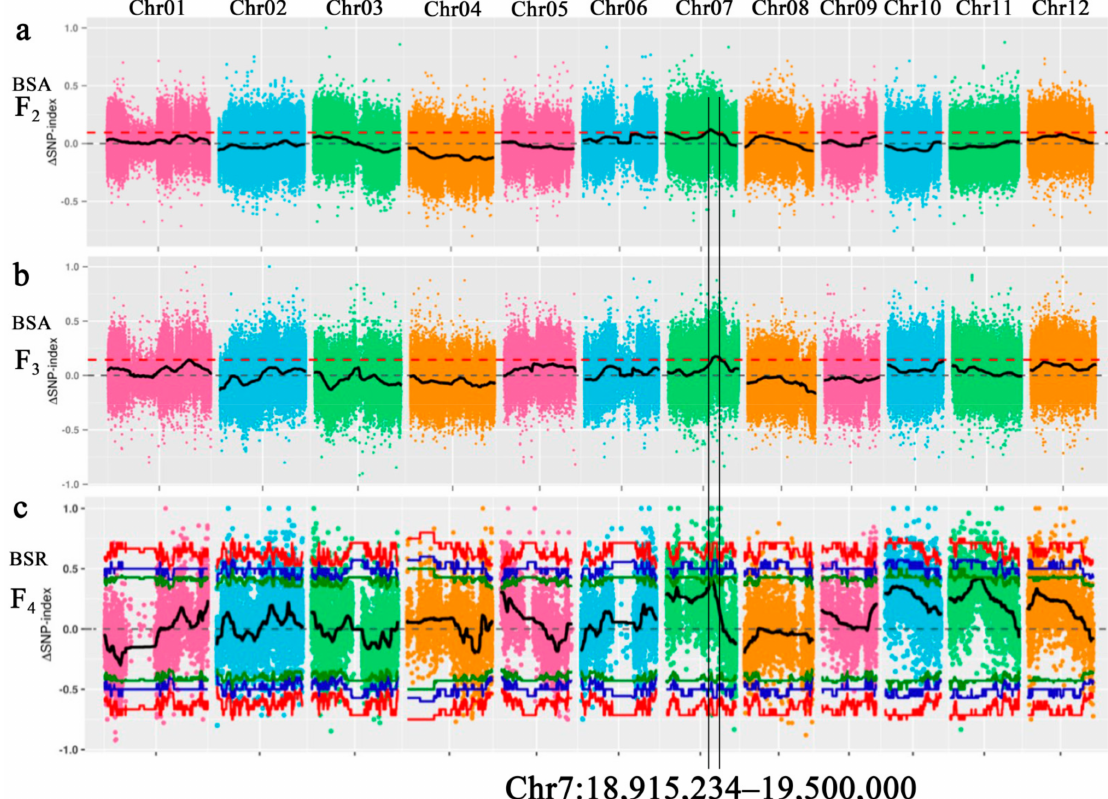
Figure 3. Identification of the hot-region for high fertility through the single nucleotide polymorphism SNP-index association analysis method. The X -axis represents the position of 12 chromosomes of rice and the Y -axis represents the ∆ (SNP-index). The color dots represent the ∆ (SNP-index) value of every SNP locus. The black lines show the ∆ (SNP-index) value of fitting results. ( a ): The ∆ (SNP-index) graph of F 2 generation. ( b ): The ∆ (SNP-index) graph of F 3 generation. ( c ): The ∆ (SNP-index) graph of F 4 generation. The red dotted line shows the association